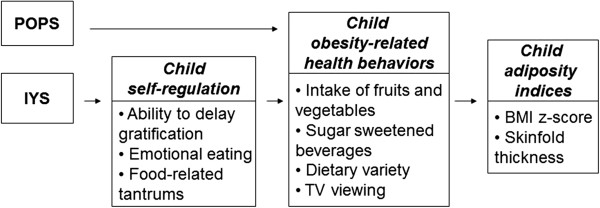
Conceptual model.